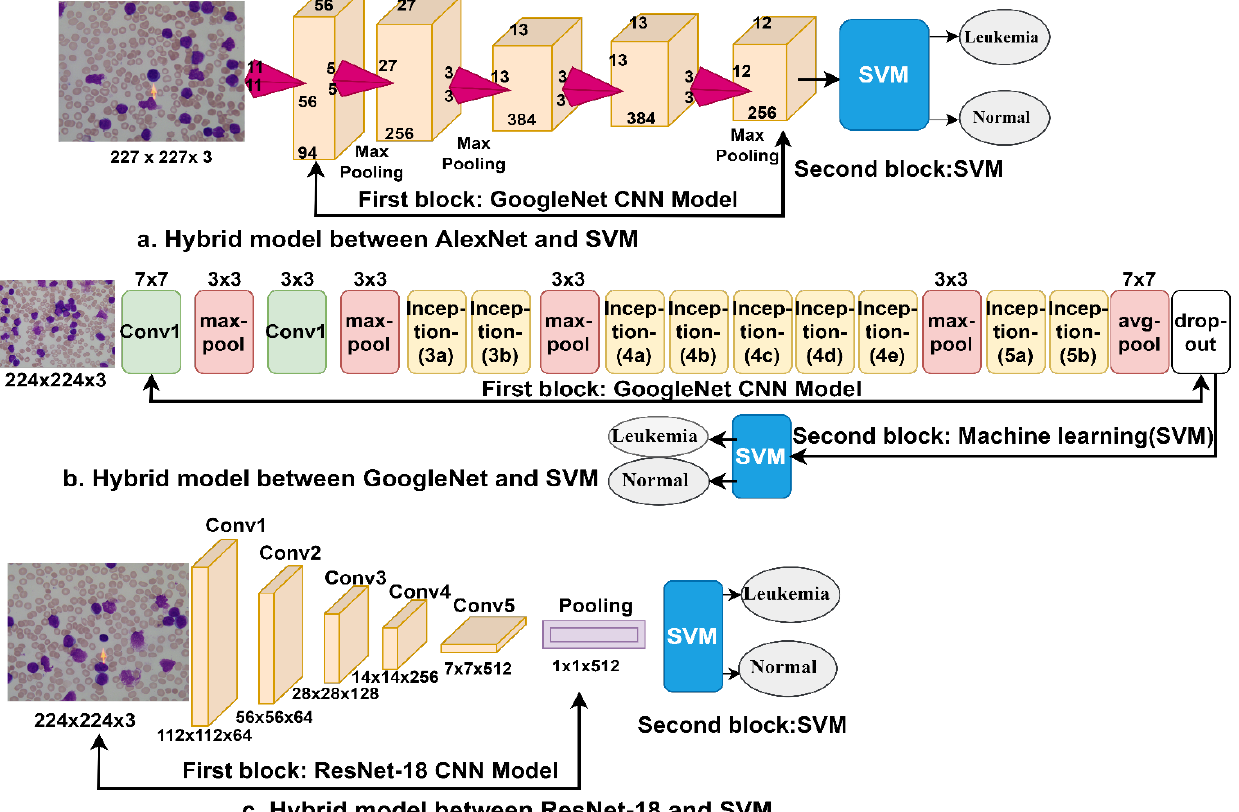
Figure 11. Deep learning–machine learning hybrid techniques: ( a ) AlexNet + SVM; ( b ) GoogleNet + SVM; and ( c ) ResNet-18 + SVM.